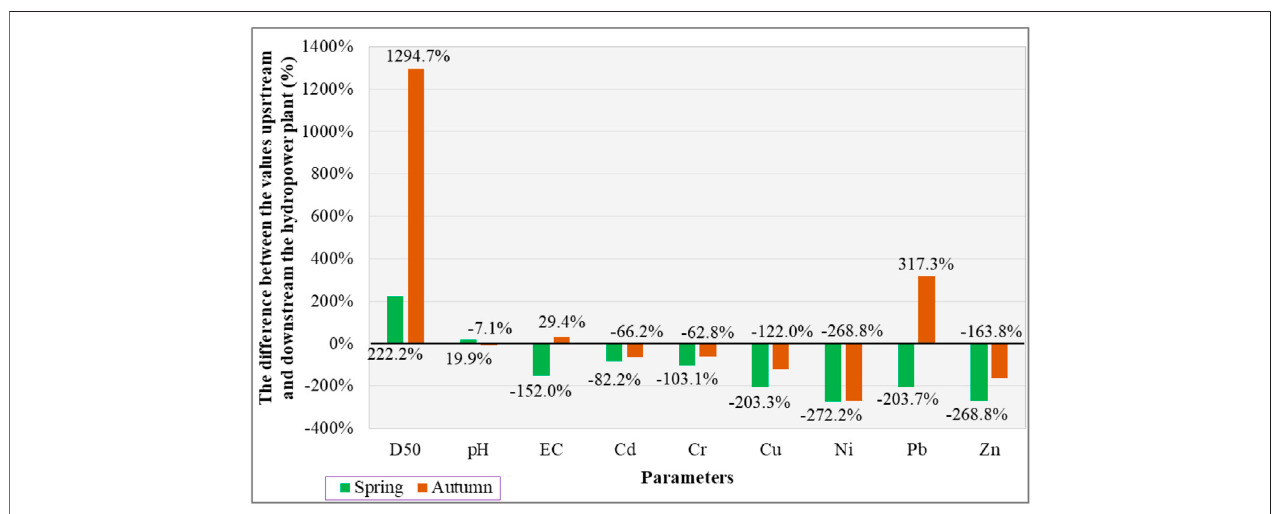
FIGURE10| Percentagechangesinthevaluesofbottomsedimentparameters – comparisonoftheresultsfromthepointslocatedclosesttothehydropowerplant on the Bystrzyca River.